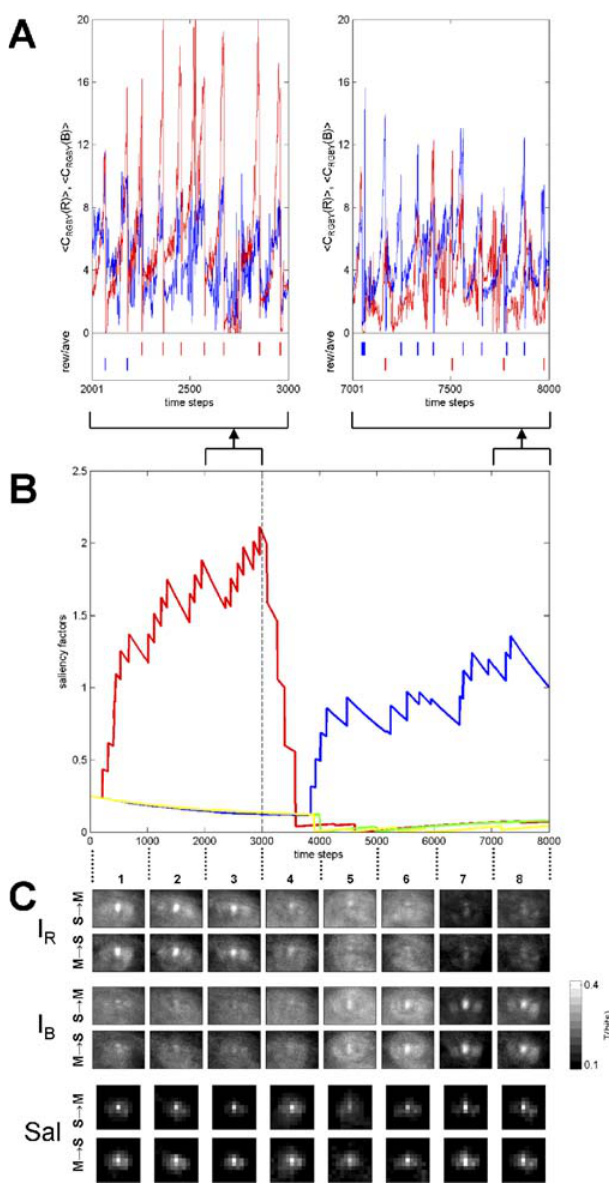
Figure 5. Changes in Behaviour, Saliency Factors, and Information Flow (Transfer Entropy) in Strider Data are from a single representative experiment, collected over 8,000 time steps. Strider navigated though its enclosure and approaching and ‘‘ tasting ’’ salient objects. Saliency (contingency) was under experimental control, and was switched at t ¼ 3,000 from red ¼ rewarding and blue ¼ aversive to red ¼ aversive and blue ¼ rewarding. (A) Traces of average activation levels in color-selective maps Col RGBY , for red and blue (green and yellow are not shown for clarity), sampled between t ¼ 2,001 and 3,000 (left plot) and t ¼ 7,001 and 8,000 (right plot). Raster plot at the bottom gives corresponding rewarding (rew, top trace) and aversive (ave, bottom trace) events, with the color of the plot corresponding to the dominant color present in the center of the visual field at the time of the reward/aversive signal. (B) Traces of saliency factors g RGBY over time. Note reversal of red/blue at the time of contingency switch (t ¼ 3,000). (C) Transfer entropy maps for sensory variables S ¼ I R (top rows), S ¼ I B (middle rows), and S ¼ Sal (bottom rows). M ¼ eye (pan-tilt) amplitude throughout. Gray scale ranges from 0.1 to 0.4 bits. DOI: